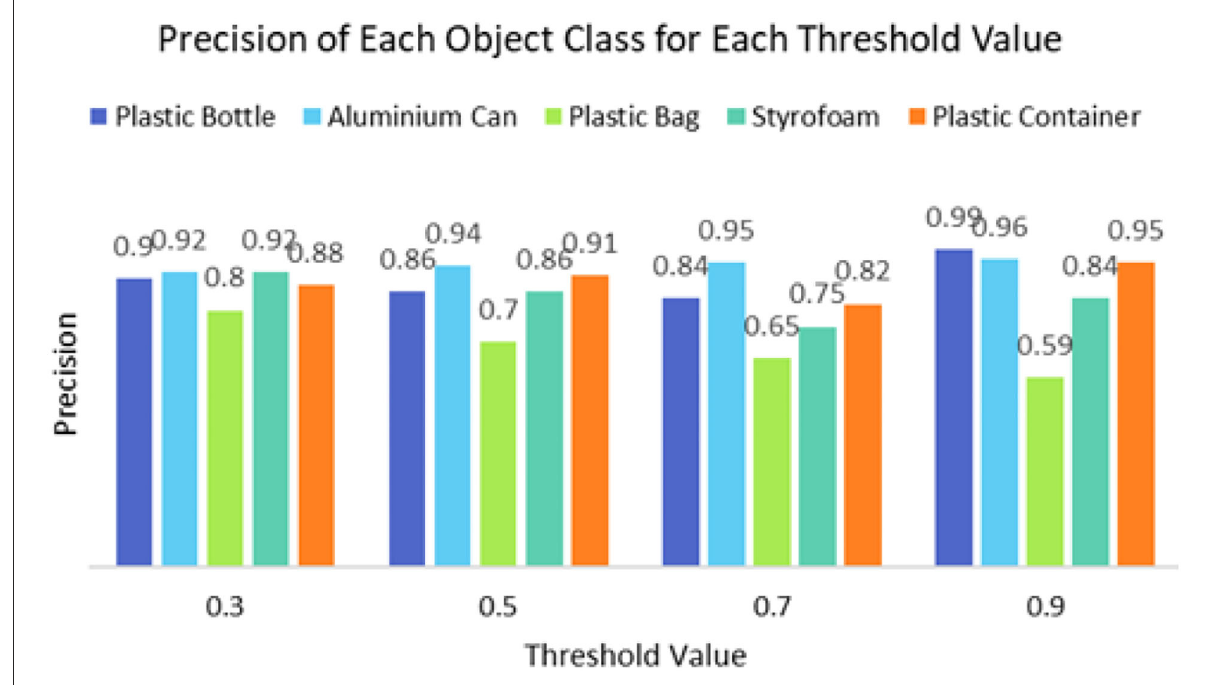
FIGURE10 The precision of the object detector using a different threshold value.